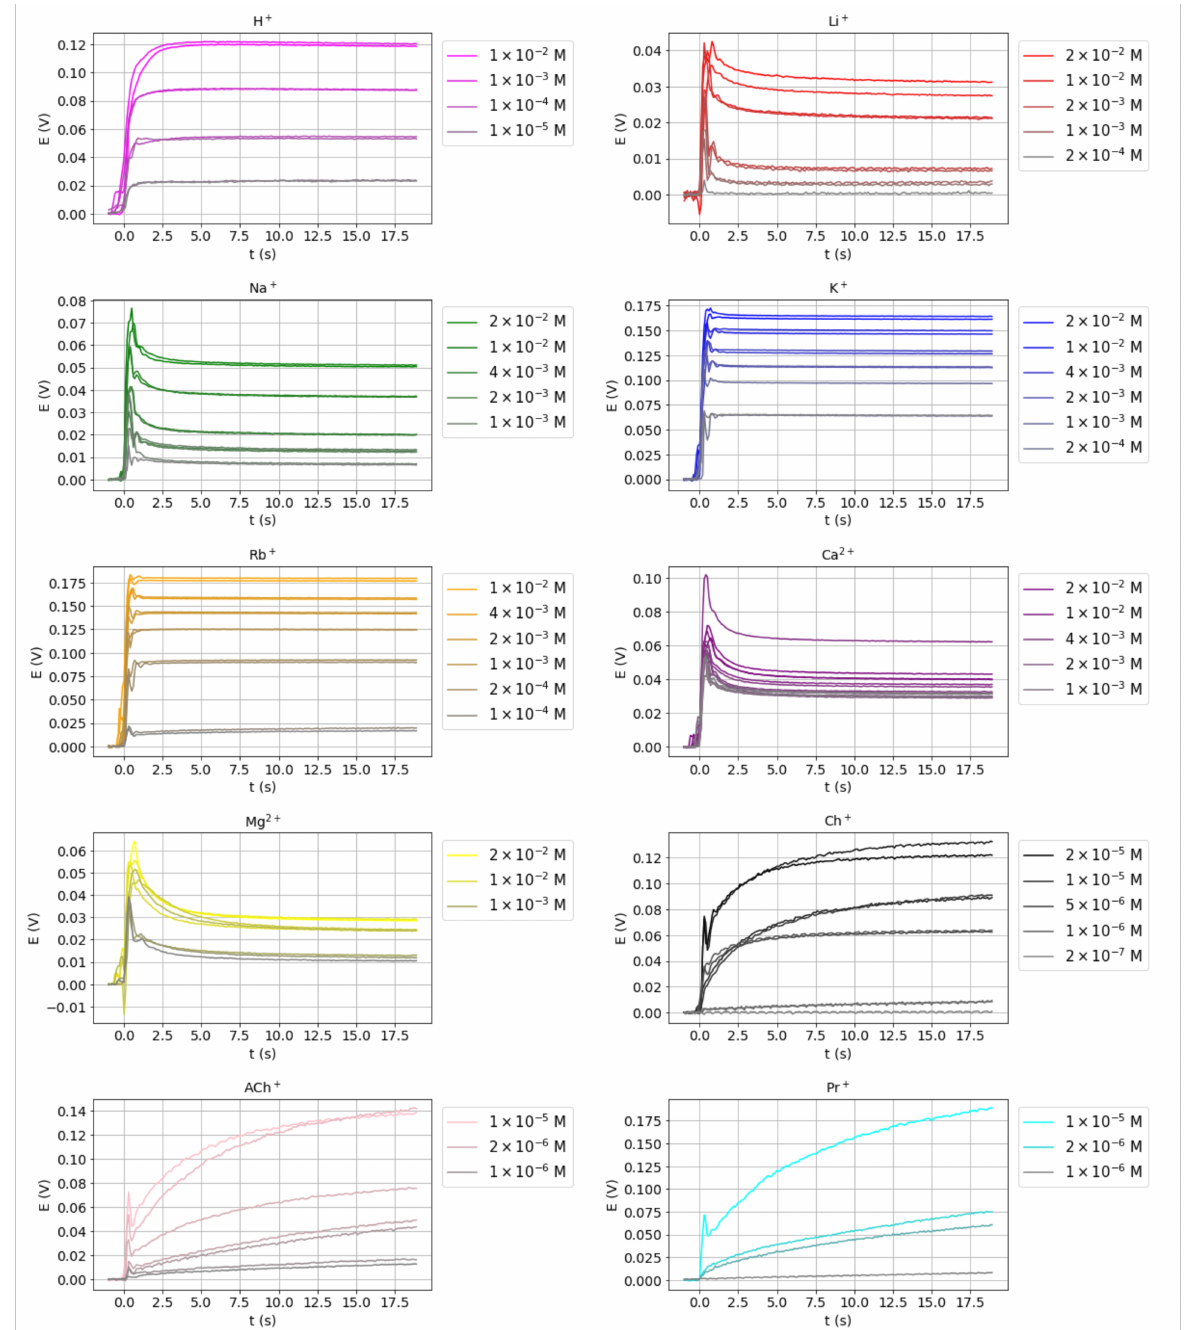
Figure 1. Transient potential signals obtained for the ions studied at different concentrations. From the apparent selectivity coefficient values of the ions studied with respect to K + obtained as described in Section 2.5 (Table 1), it can be observed that the type of transient signal obtained for each ion depends of the magnitude of the selectivity coefficients. Thus, the first type of transient signal was obtained for ions with log K K,j ≤ − 2.2 (low values), the second type for log K K,j values between − 0.7 and 0.6 (medium), and the third type for log K K,j ≥ 1.6